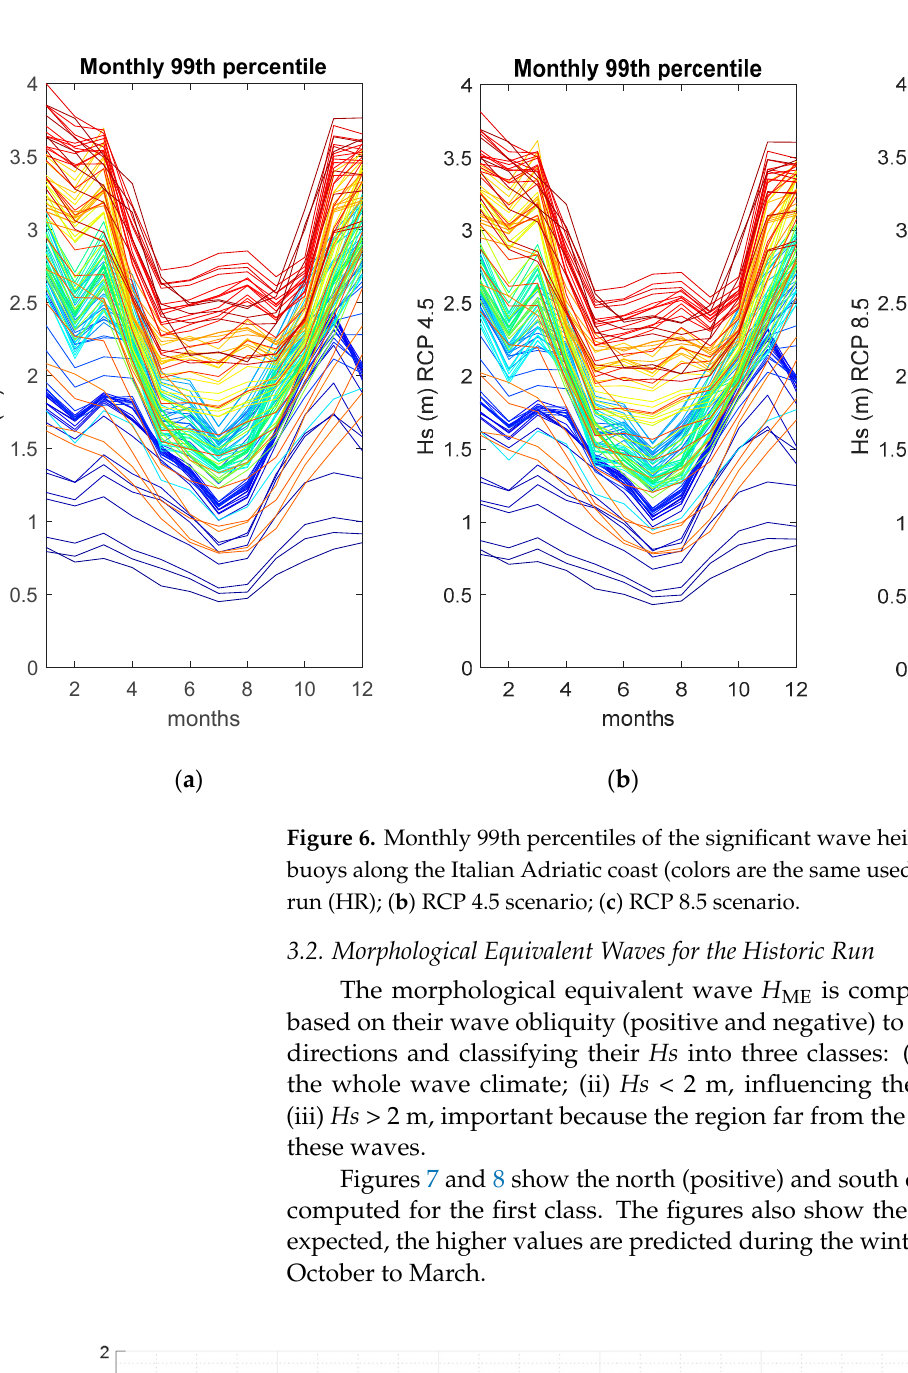
11 of 18 Figure 5. Comparison between the 30-year return period significant wave heights Hs computed at the 120 virtual buoys along the Italian Adriatic coast relative to the historic run (HR) and future scenario runs: ( a ) historic run vs. RCP 4.5 scenario; ( b ) historic run vs. RCP 8.5 scenario. Figure 6 shows the monthly trends of the 99th percentiles for all the points. Higher waves are correctly predicted for the winter season (from October to March, [34]), and the trend remains unchanged for the future scenario with a decrease in terms of Hs magnitude